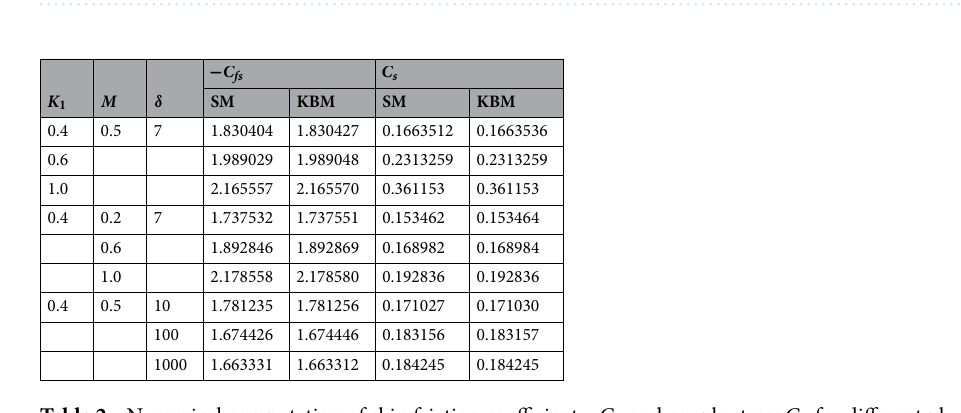
Table 2. Numerical computation of skin friction coefficient − C fs and couple stress C s for different physical flow parameters.